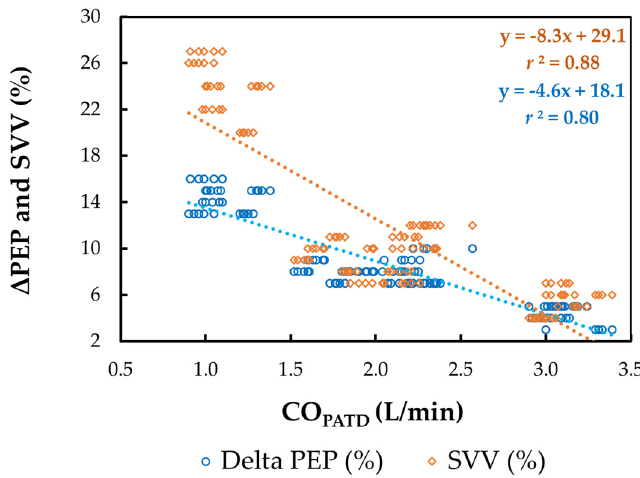
Figure 7. Scatterplot of cardiac output (CO) measured using pulmonary artery thermodilution (CO PATD ) versus stroke volume variation (SVV) and variation in pre-ejection period ( ∆ PEP) in six healthy, isoflurane-anesthetized Beagle dogs across five timepoints during four hemodynamic events (baseline, hemorrhage, autologous blood transfusion, and colloid infusion), thus yielding 120 paired observations. Th orange dotted line with orange solid diamonds represents the best-fit correlation for SVV and the blue dotted line with blue solid circles represents the best-fit correlation for Δ PEP.